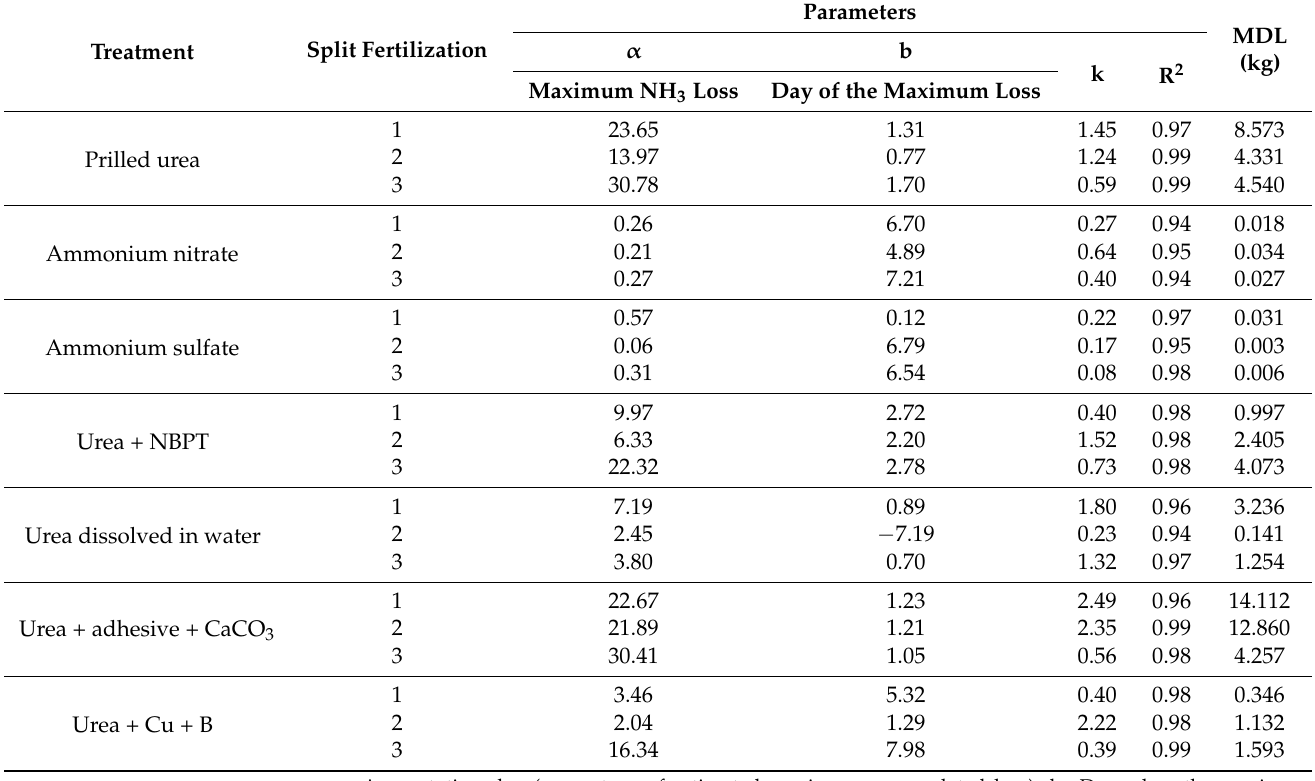
Table 1. Regression parameters adjusted for the accumulated and maximum daily losses of N-NH 3 from conventional and stabilized N fertilizers in the 2015/2016 crop season.